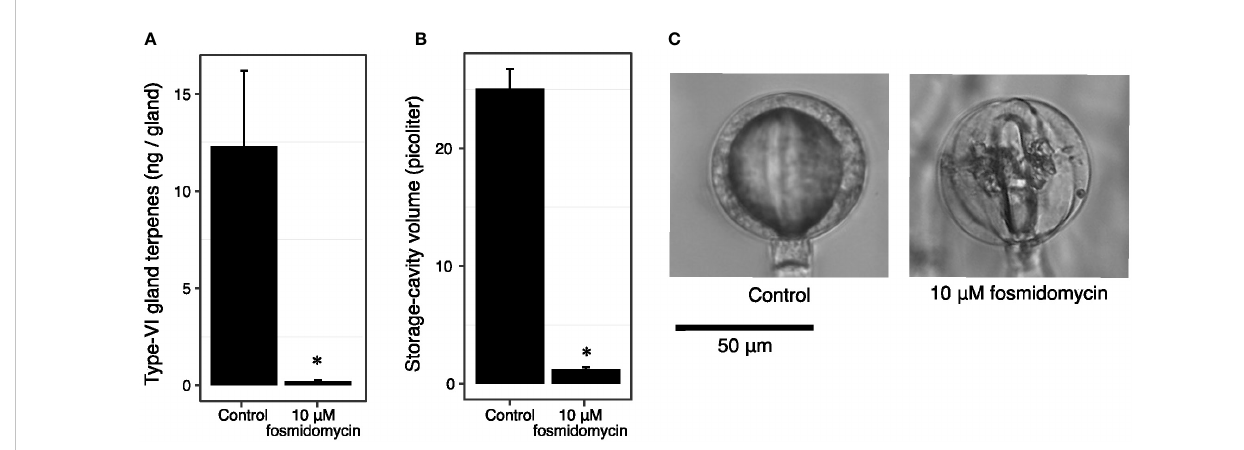
FIGURE 4 Fosmidomycin treatment of PI127826 cuttings reduces terpene content and storage cavity volume of type-VI trichomes. Cuttings of PI127826 (n = 3) were grown for 14 days in hydroponic solution supplied with or without 10 m M fosmidomycin. (A) Quanti fi cation of total mono-and sesquiterpene terpene levels in type-VI glands. (B) Volume of the storage cavity. (C) Representative photographs of a type-VI head displaying the central storage cavity after 14 days under control conditions or with fosmidomycin treatment. Signi fi cant differences are annotated with an asterisk: T-test p <